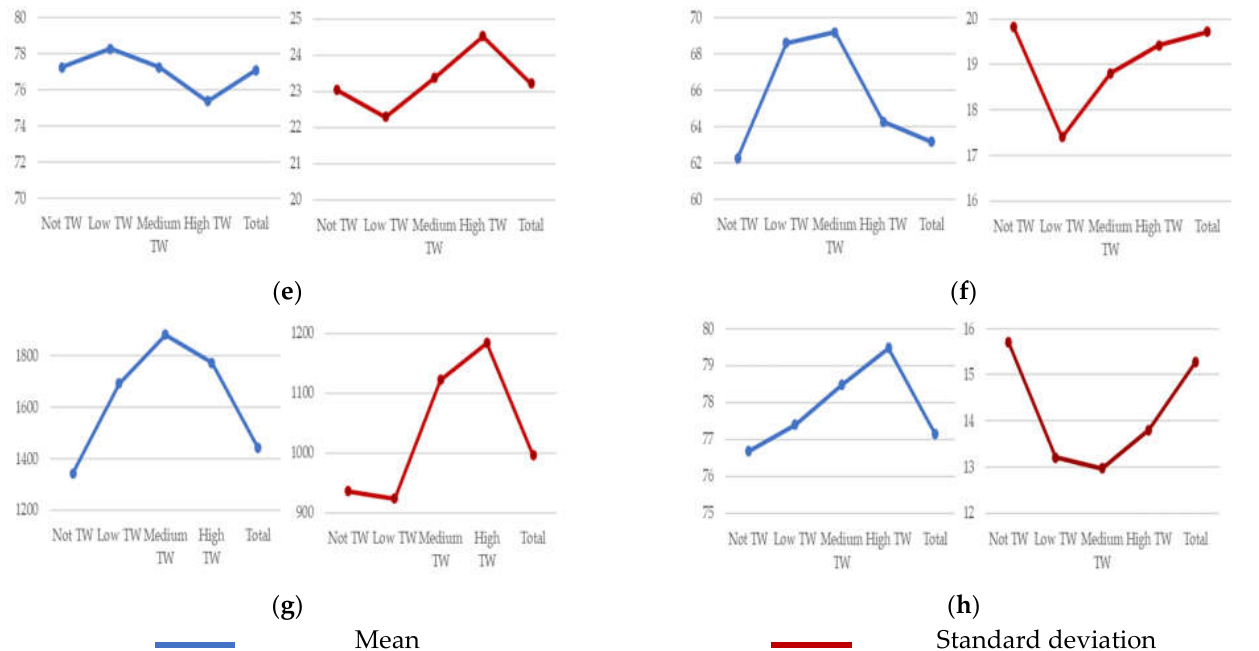
Figure 1. Mean and standard deviation of each work index, by intensity of teleworking, Europe 35 (weighted). Mean in blue and standard deviation in red. Source: Own elaboration based on 6th EWCS data. ( a ) JQI Physical Environment Index; ( b ) JQI Work Intensity (rev) Index; ( c ) JQI Skills and Discretion Index; ( d ) JQI Working Time Quality Index; ( e ) JQI Social Environment Index; ( f ) JQI Prospects Index; ( g ) JQI Earnings; ( h ) Work Engagement Index.